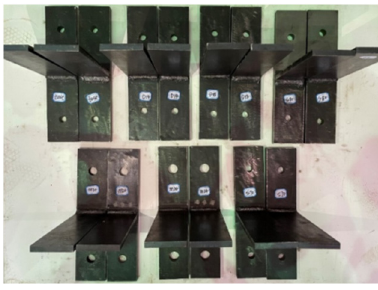
Figure 3. Tension test specimen. Table 3. Size and preload force of T-stub.